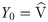
Relation between direct drug effect and prophylactic efficacy.The relation between direct drug effect η and prophylactic efficacy φ (reduction in infection) is shown for different drug classes utilizing the viral model depicted in Fig 1 with parameters stated in Table 1. Panel A: Relation between η and φ when a single virus Y0=V^ reached a replication-enabling compartment in the virus-exposed individual. Panel B: Relation between η and φ when a single early infected cell Y0=T^1 or (panel C) a late infected T-cell Y0=T^2 reached a replication-enabling compartment. Solid red lines: CRAs, solid green line: RTIs, dashed blue line: InI, dashed purple line: PIs.